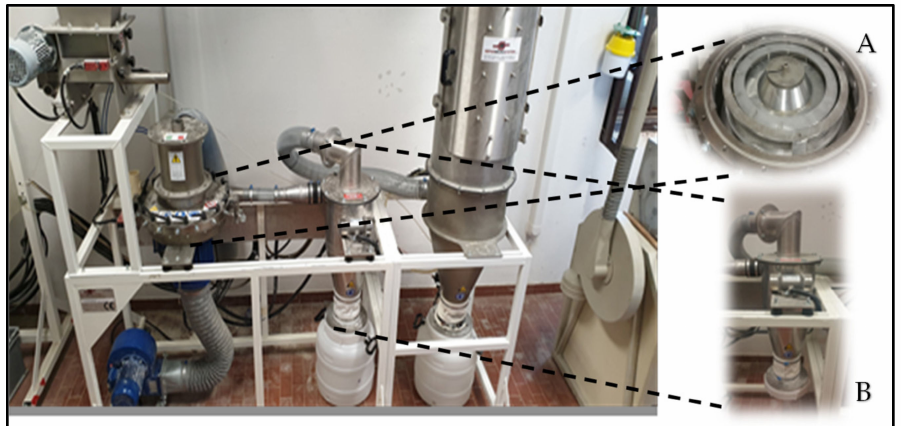
Figure 2. Micronizer pilot plant improved through the addition of a grinding chamber including a hammer crusher impeller ( A ) and a decanting collector ( B